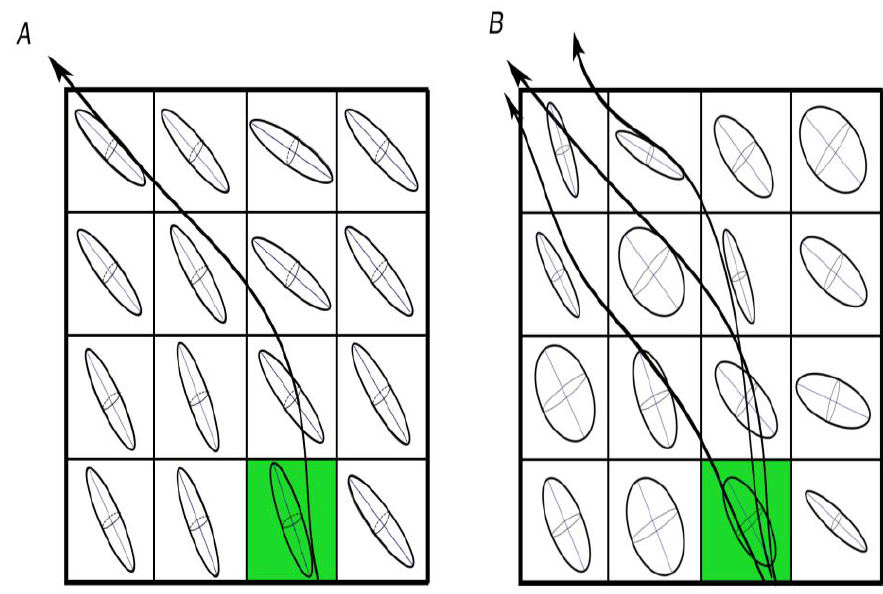
Figure 2. Visual representation of the differences between deterministic ( A ) and probabilistic; ( B ) approaches to tractography. Probabilistic approaches are considerably more extensive and computationally demanding, as they track all orientations in all voxels adjacent to the seed point (green).